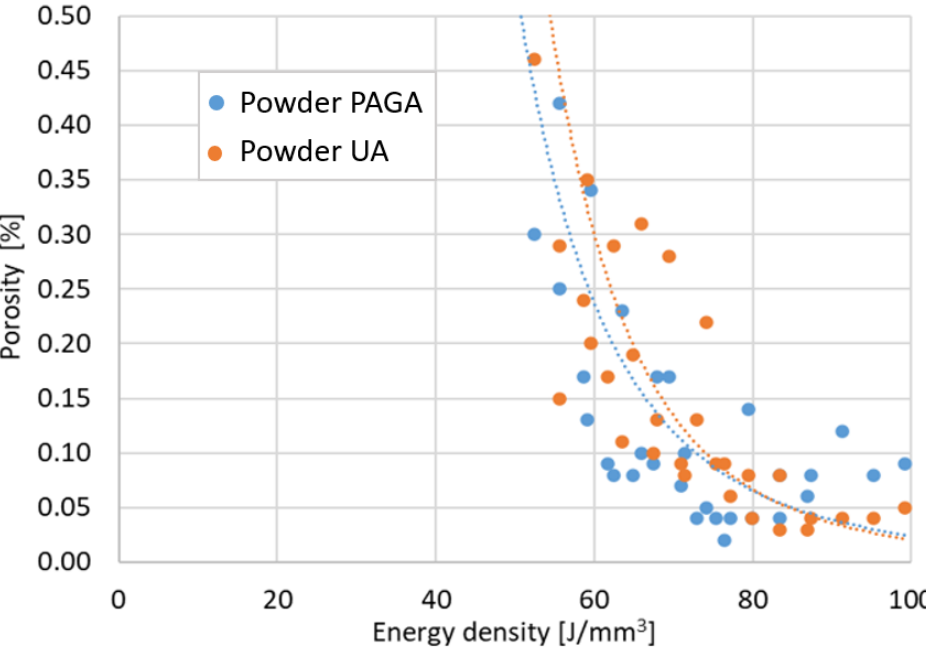
Figure 7. Sample porosity in the function of the laser energy density ρ E .